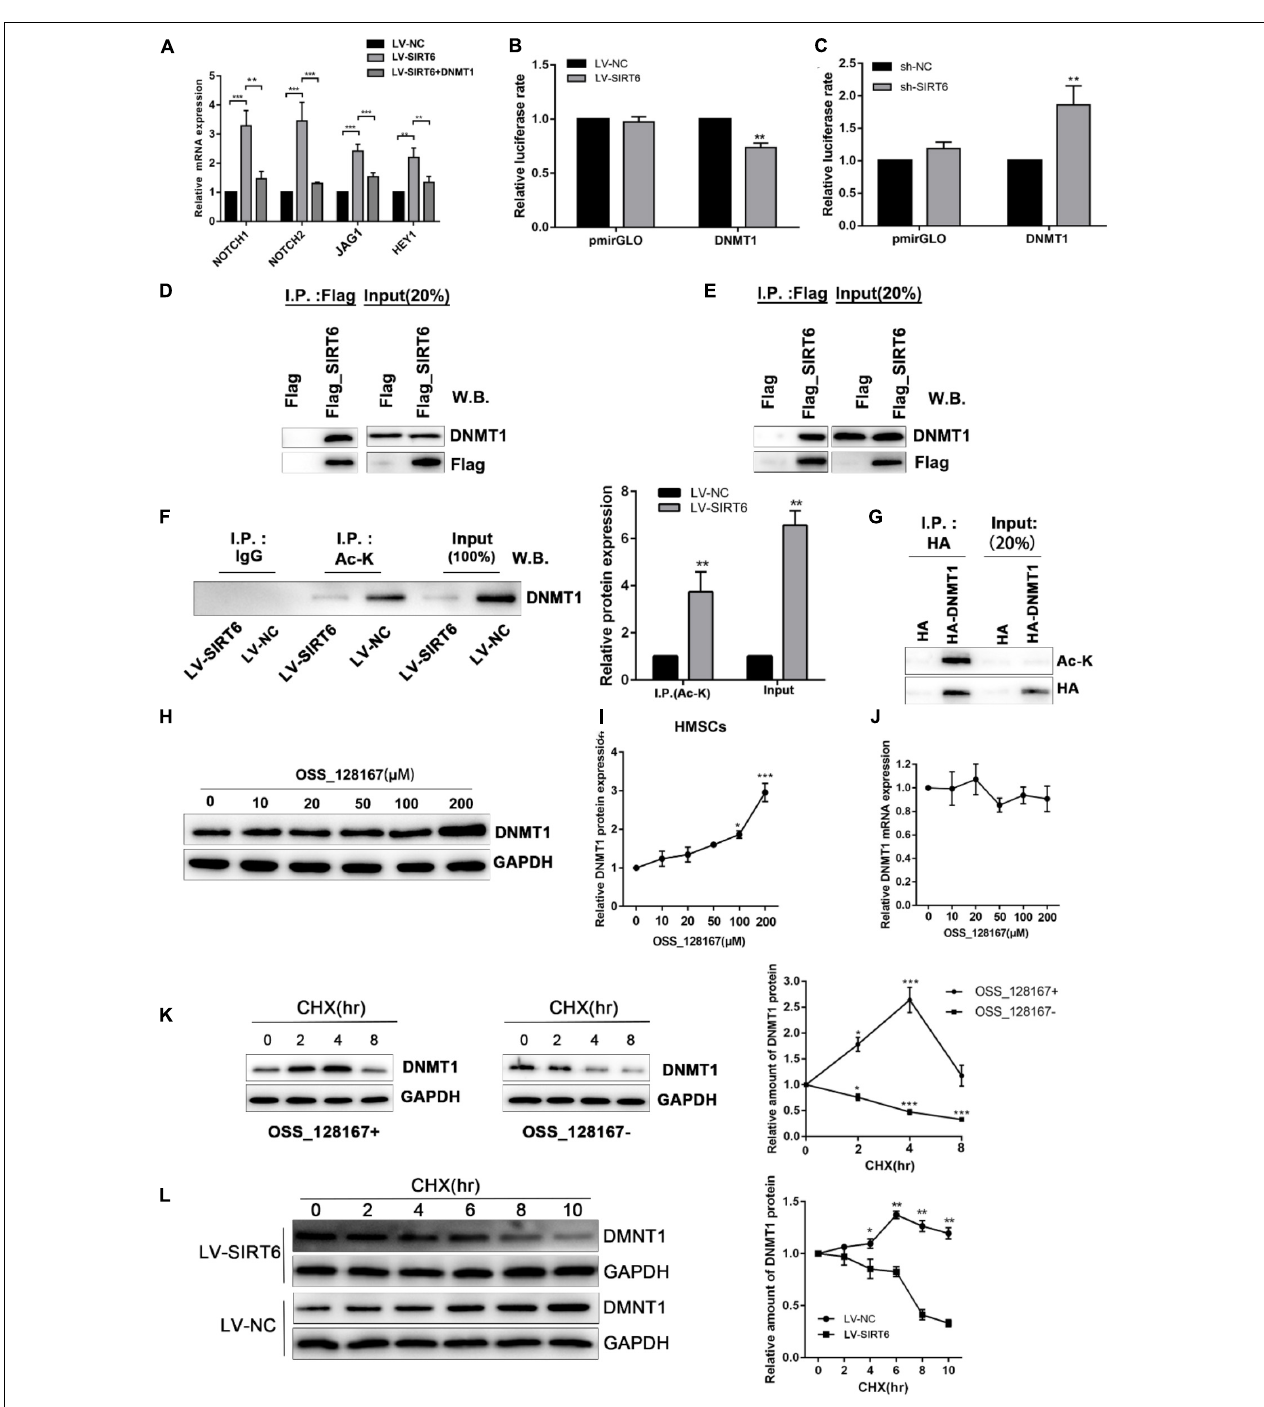
FIGURE 6 | (A) SIRT6 overexpressed hADSCs were transfected with DNMT1 plasmid, the expression of NOTCH1, NOTCH2, NOTCH2, JAG1, HEY1 were determined by RT-qPCR. (B,C) Promoter activity was assessed for DNMT1 in SIRT6 overexpressed of silenced hADSCs ( n = 3). (D,E) Immunoprecipitation (IP) analysis was performed in Flag-SIRT1-overexpressing hADSCs and 293T cells. A stable empty vector transfected cell line was established as control group. (F) IP analysis was performed with an acetylated lysine (Ac-K) antibody using flag-SIRT6-overexpressing hADSCs nuclear extracts. DNMT1 proteins levels in the Ac-K IP is shown as mean ± SEM. (G) HA-tagged Dnmt1 proteins were immunoprecipitated (IP) using an HA antibody. Acetylated proteins in the IP products were detected by western blot. (H,I) The change of DNMT1 protein expression are shown during treatment of OSS_128167. (J) The change of DNMT1 mRNA expression is shown during treatment of OSS_128167. (K) DNMT1 proteins stability in hADSCs in the present or absent of OSS_128167 was measured using a cycloheximide (CHX)-chase assay (100 mg/mL CHX) for the indicated hours. (L) Stability of the DNMT1 proteins in SIRT6 overexpressed or control hADSCs was measured using a CHX-chase assay involving 100 mg/mL CHX for the indicated hours. Data are shown as means ± SD. * p < 0.05, ** p < 0.01, *** p < 0.001.